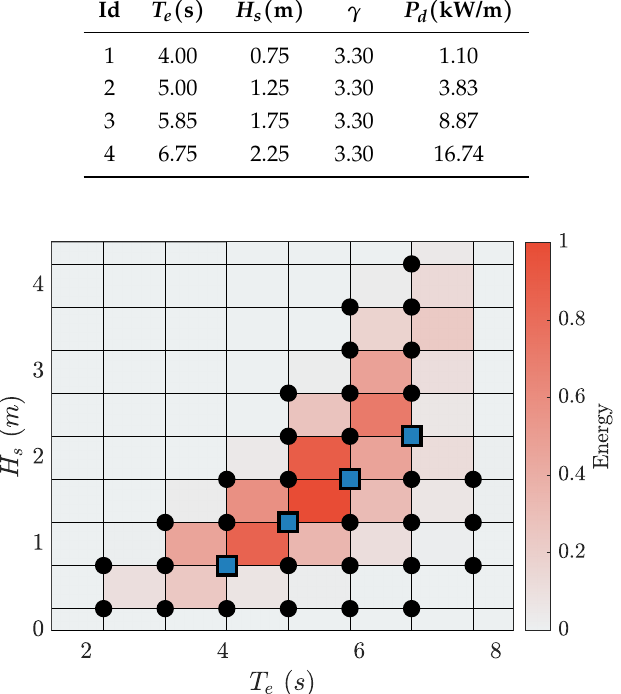
Figure 4. Normalized annual wave energy of the 35 irregular sea-states, indicated with black dots and